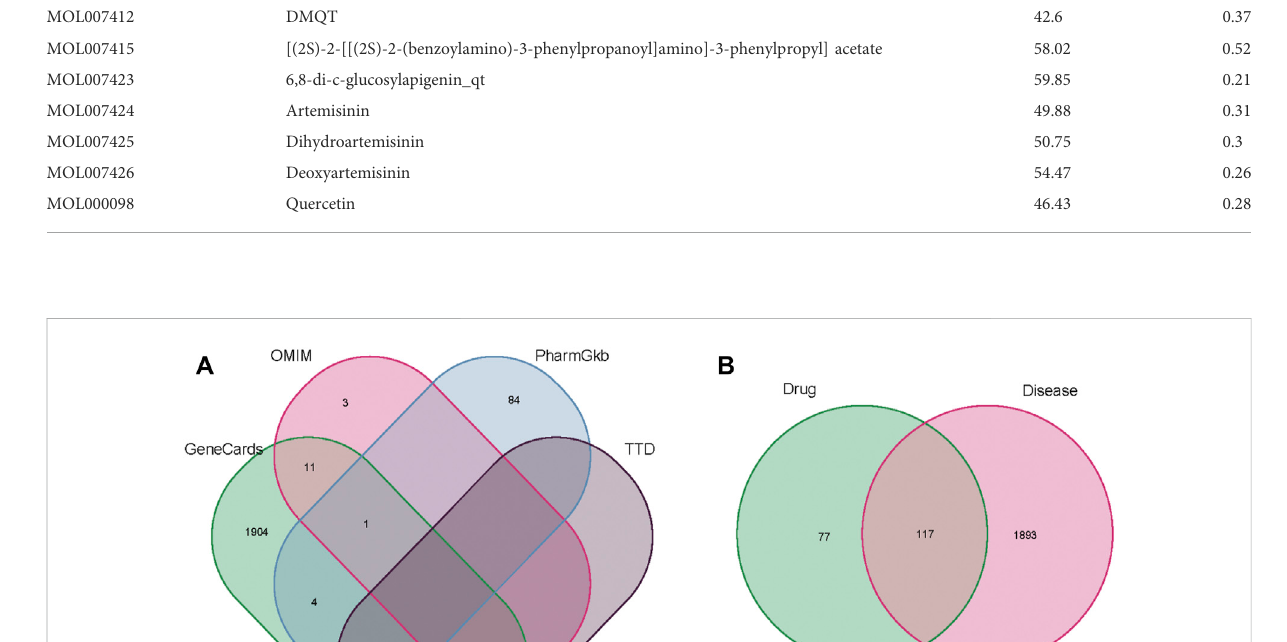
represented the number of targets involved in each entry. The higher the signi fi cance of the entry, the redder it was. As shown in Figure 3, in biological processes, A. annua was mainly associated